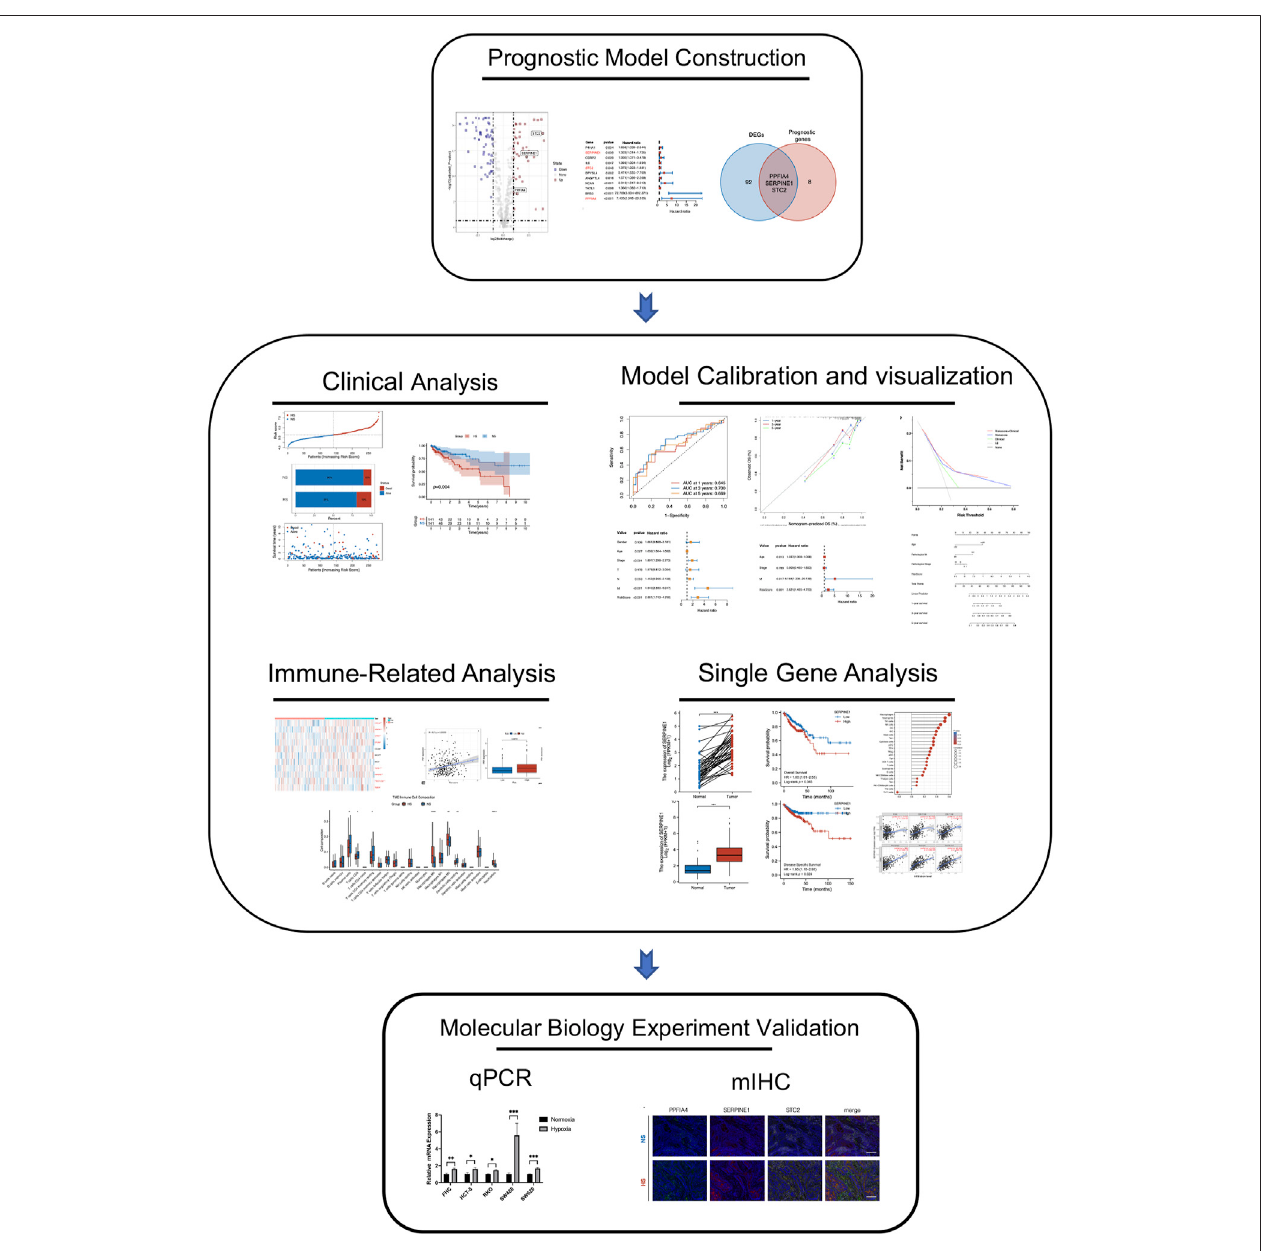
FIGURE 1 | The complete pipeline of the present study. It contained three major parts, including prognostic model construction, analyses between different subgroups (clinical, immune-related, calibration, bio-functional, and single-hub gene analyses), and multiple immunohistochemistry validation.